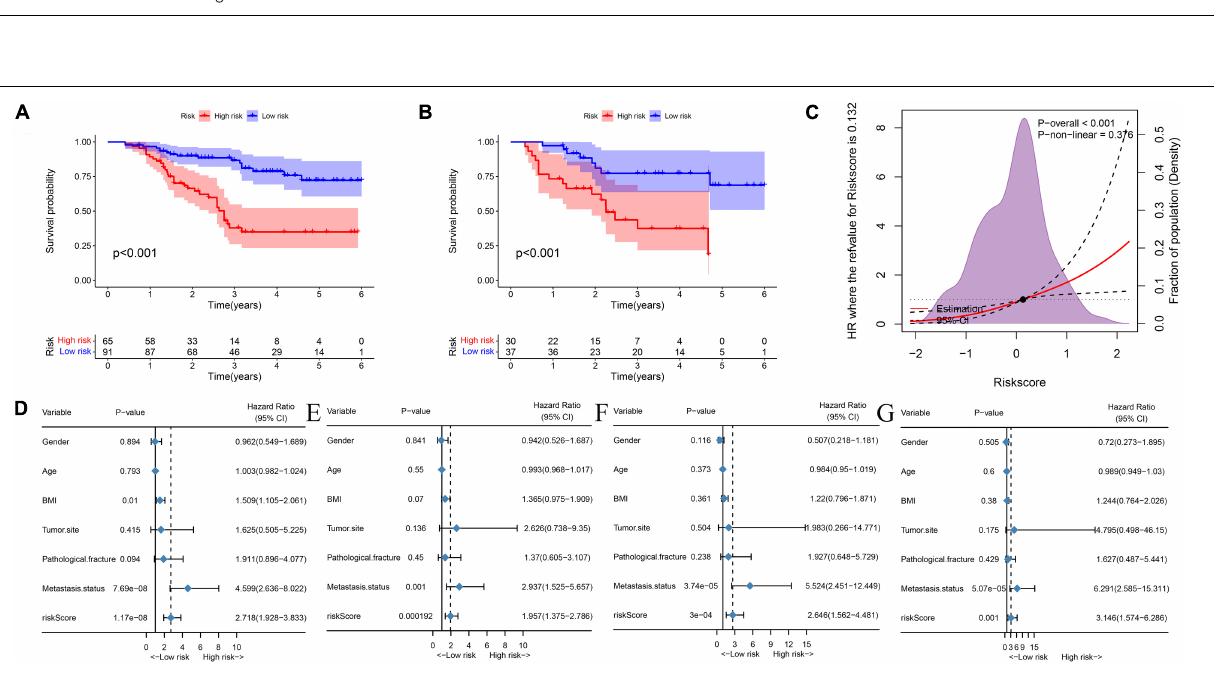
Frontiers in Nutrition |